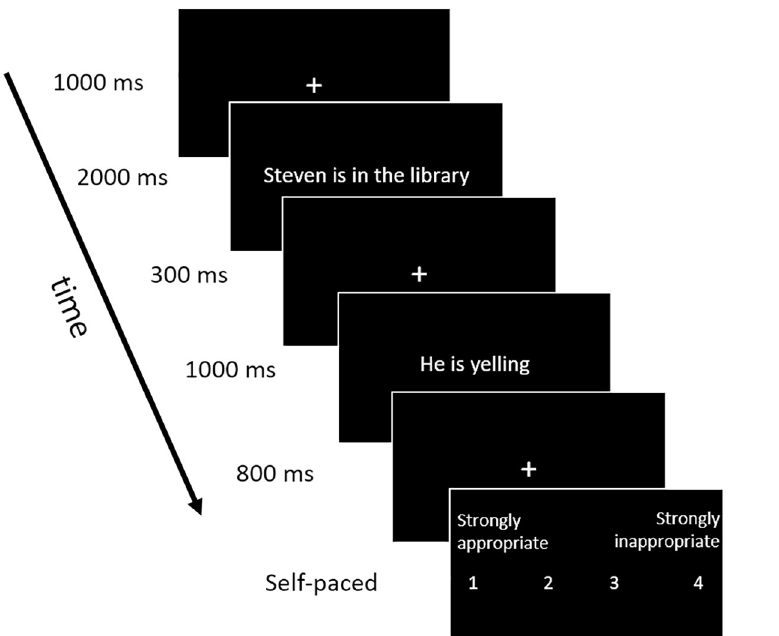
Fig 1. Example of a trial in the social norm violation